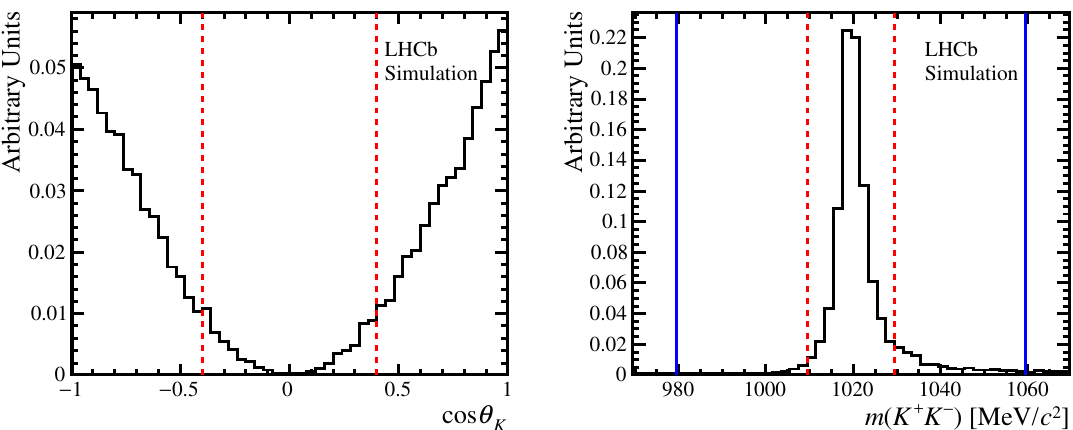
Figure 2. Distributions of (left) cos (cid:18) K and (right) m ( K + K (cid:0) ) in B + ! D + (cid:30) decays, as determined s from simulated events. The vertical lines represent the limits of the two categories used for each variable. In the m ( K + K (cid:0) ) distribution, the area within the dashed red lines represents the (cid:30) signal region, and the two areas between the dashed red and blue lines represent the (cid:30) sideband region. The B + ! D + (cid:30) signal decays are seen to primarily contribute to the (cid:30) signal region and s the j cos (cid:18) K j > 0 : 4 category.